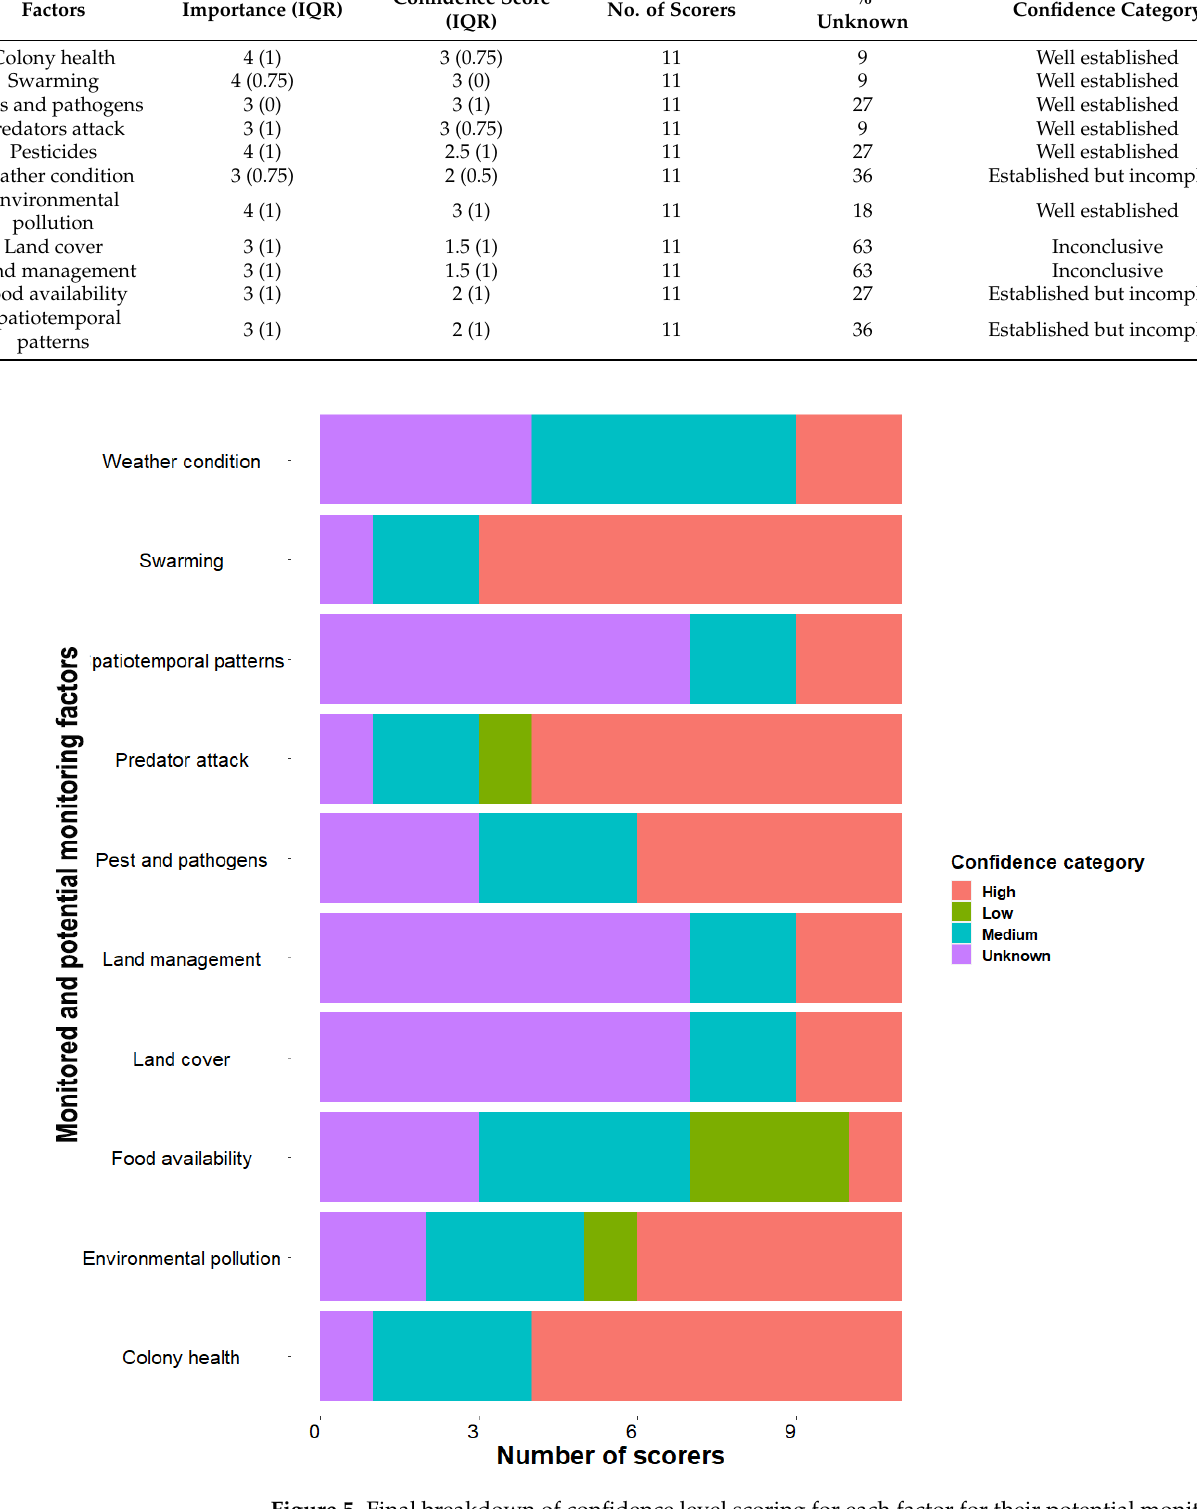
Figure 5. Final breakdown of confidence level scoring for each factor for their potential monitoring via honeybee colony acoustics.